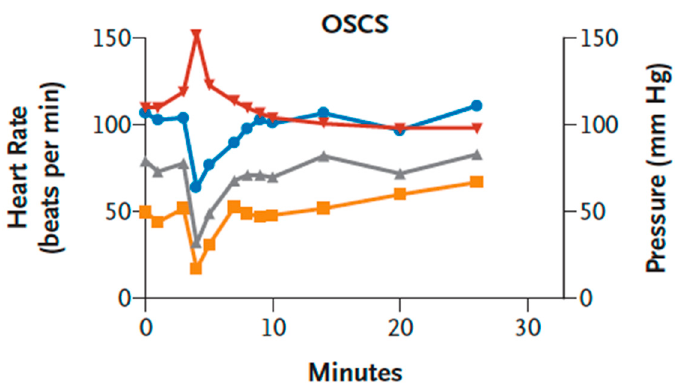
Figure 5. Hemodynamic effects of oversulfated chondroitin sulfate (OSCS) in pigs. Anesthetized Yorkshire crossbred pigs (3–6 pigs per group) were treated with a single intravenous bolus (5 mg per kilogram) of synthetic OSCS. Representative data for the heart rate (red), the mean arterial pressure (gray), the systolic blood pressure (blue), and the diastolic blood pressure (yellow) are shown. Figure reproduced from Ref. [29], with permission.